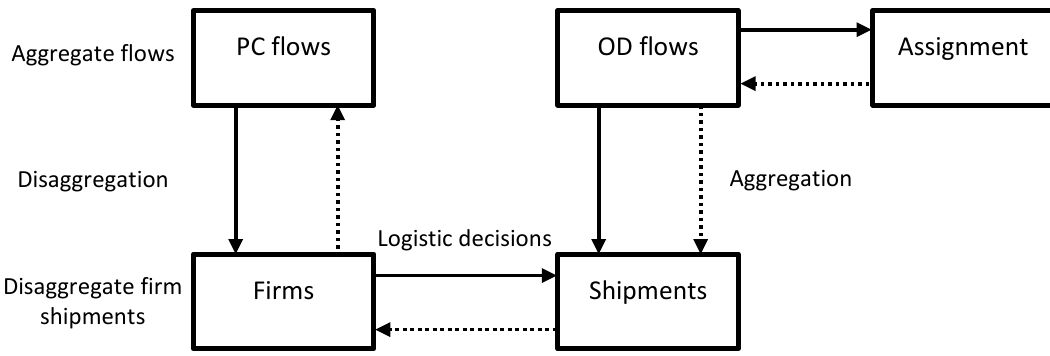
Figure 1. ADA structure of the national freight transport model system (de Jong et al.,